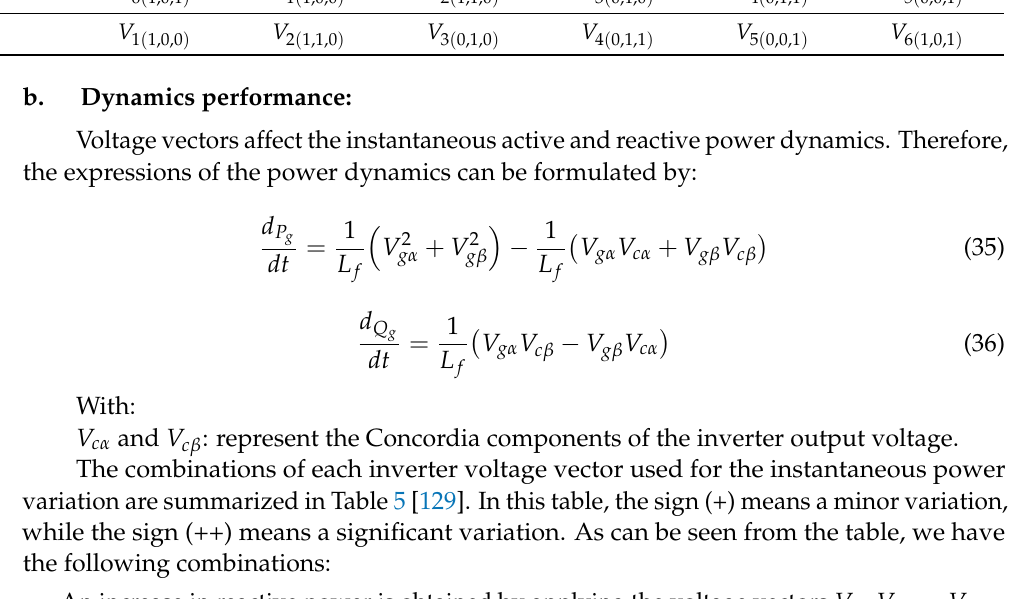
Table 5. Instantaneous variations of active and reactive powers due to applied voltage vectors.